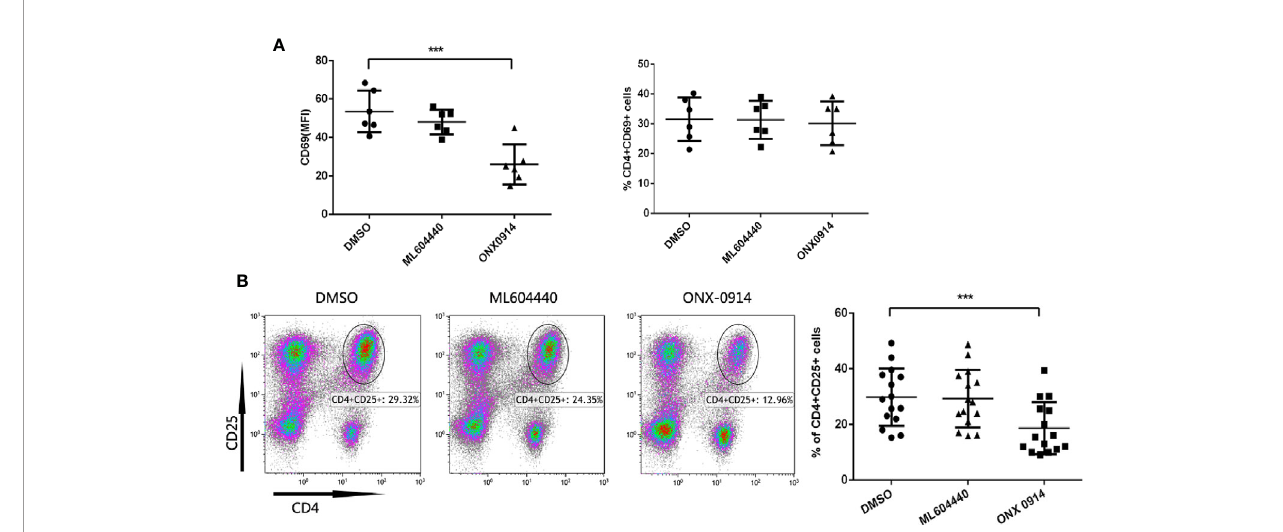
FIGURE 4 | ONX-0914 decreased activation level of T cells from immune thrombocytopenia (ITP) patients. (A) Expression of CD69 in CD4+T cells was analyzed by fl ow cytometry. The PBMC cells in the presence/absence of ML604440 or ONX-0914 were co-stimulated with anti-CD3/CD28 antibodies for 10 h. Shown are the MFI (left) and %(right) of CD69. ONX-0914 (30 nM) reduced the MFI of CD16 cells in CD4+ T cells without in fl uence of % CD4+CD16+ T cells. (B) Expression of CD25 in CD4+T cells was analyzed by fl ow cytometry. The PBMC cells in the presence/absence of ML604440 or ONX-0914 were co-stimulated with anti-CD3/ CD28 antibodies for 72 h. ONX-0914 (30 nM) reduced the percentage and number of CD4 + CD25 + cells in ITP patients than ML604440 (300 nM) and DMSO. ***P <